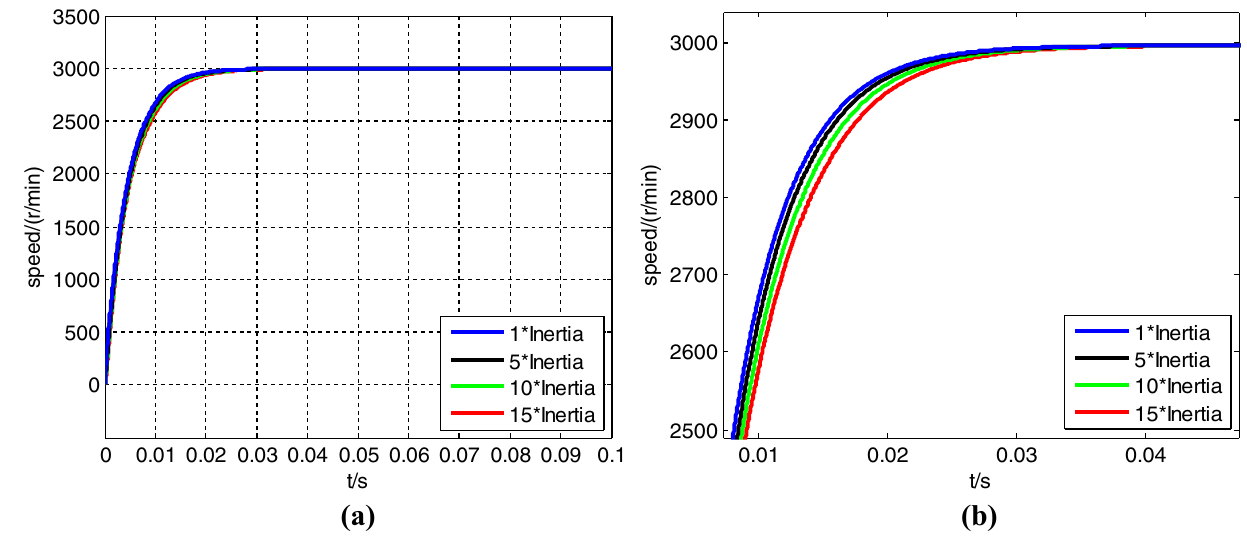
Fig. 13 The comparison of speed tracking with varying inertia: a speed response curve of 0–0.1 s, b transient speed response curve of 0–0.05 s